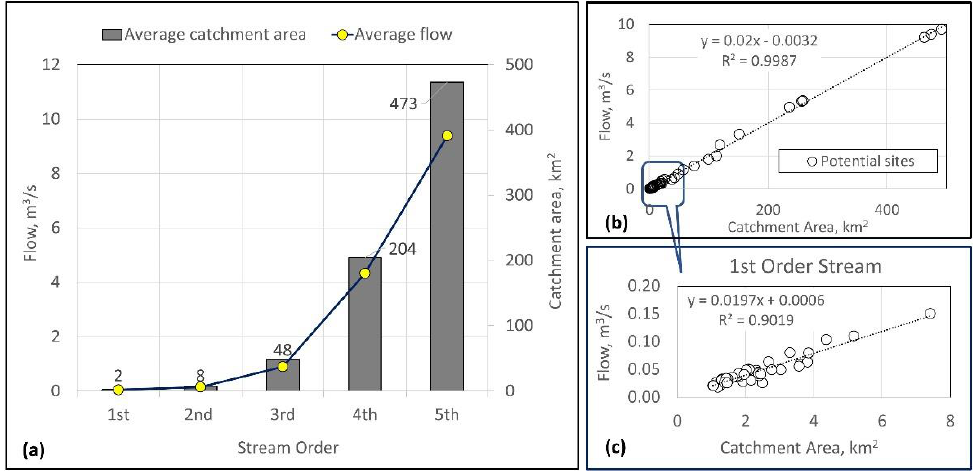
Figure 10. Flow estimates, stream order, and catchment area of the identified sites. ( a ) Average catchment area and flow by stream order. ( b ) Flow-catchment area relationship under first-order stream. ( c ) First stream order potential sites ’ flow-catchment area relationship.